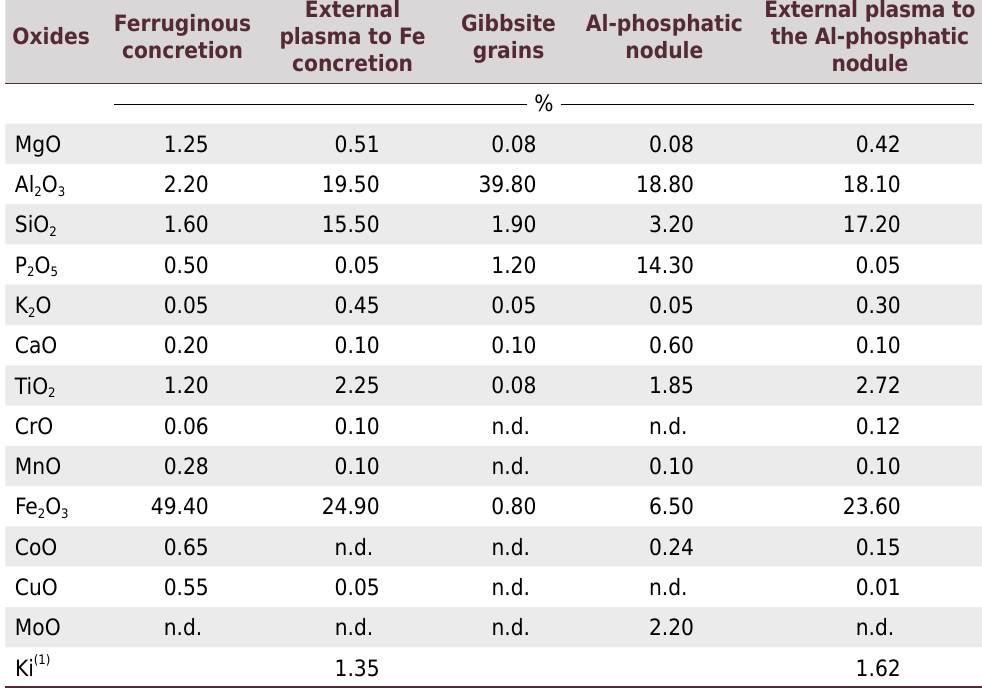
Table 8. SEM-WDS microchemical analysis of selected pedofeatures of the Bw 2 horizon in the P 7 - Geric Rhodic Petroplinthic Ferralsol (Clayic, Dystric); Coromandel